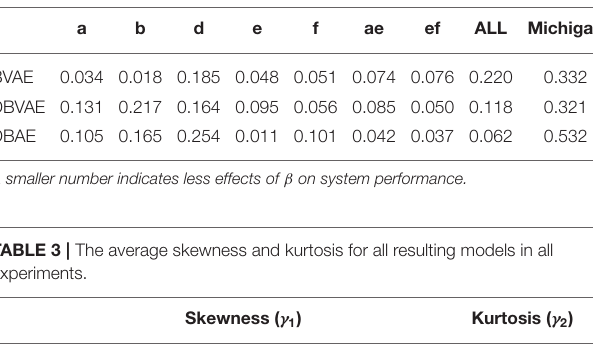
TABLE 3 | The average skewness and kurtosis for all resulting models in all experiments. Skewness ( γ 1 ) Kurtosis ( γ 2